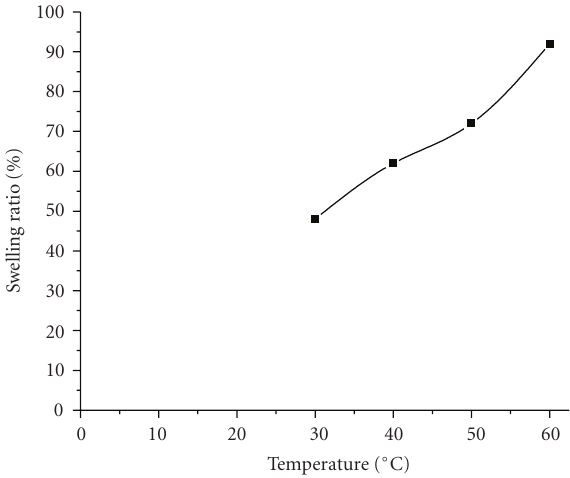
Figure 8: Swelling percentage of (IPP-g-MMA) as function of percentage of grafting.